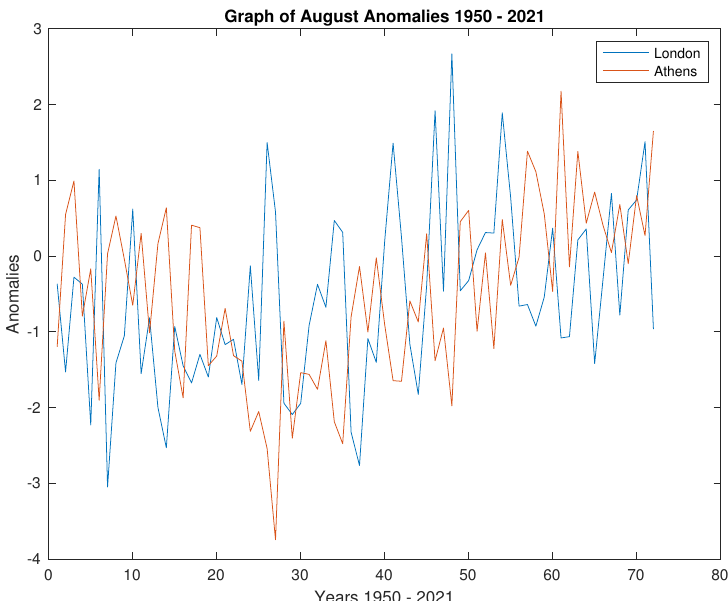
Figure 19. Graph of August Anomalies 1950–2021.